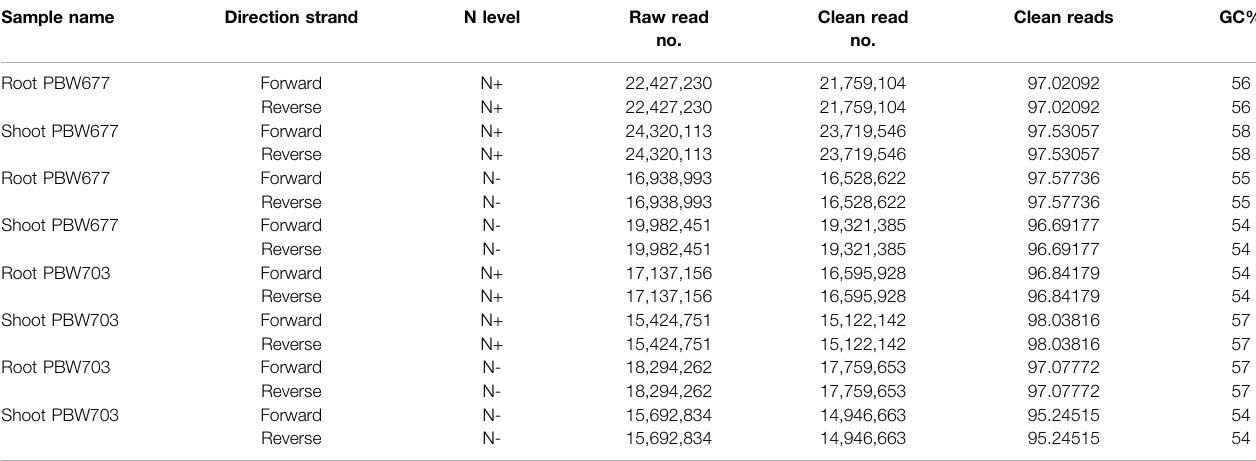
TABLE 1 | Quality of transcriptomics sequenced data of root and shoot tissues of PBW677 and PBW703 genotypes. Sample